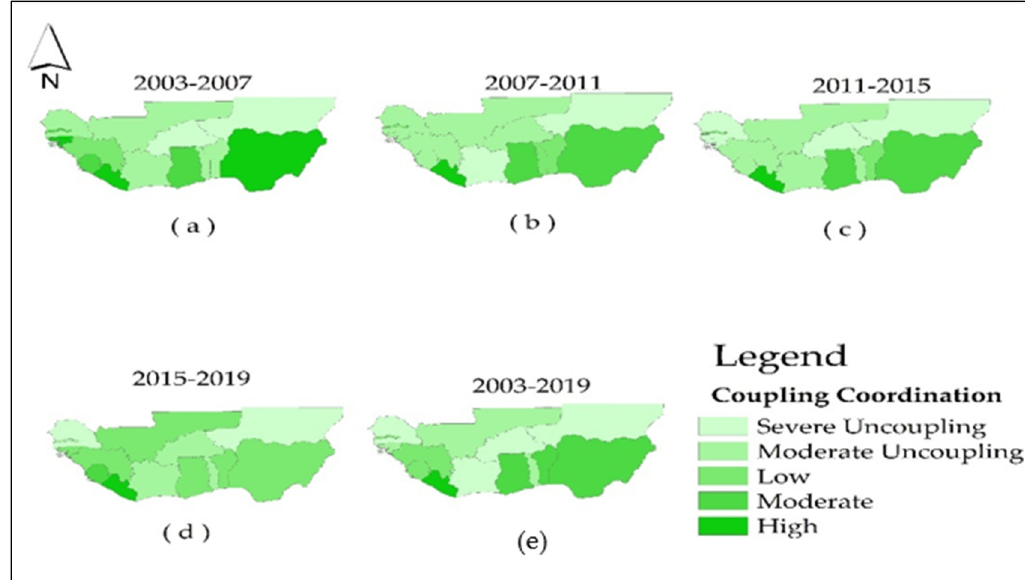
Figure 5. ( a – d ) shows the coupling coordination between population growth and the built-up area in 2003–2007, 2007–2011, 2011–2015, and 2015–2019, respectively, and ( e ) shows the study period of